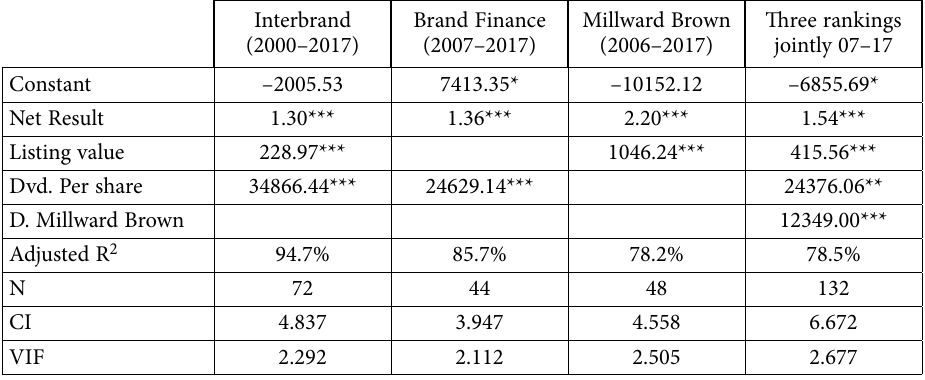
Table 6. The linear regression results for the high-value brands of the Consumer electronics industry